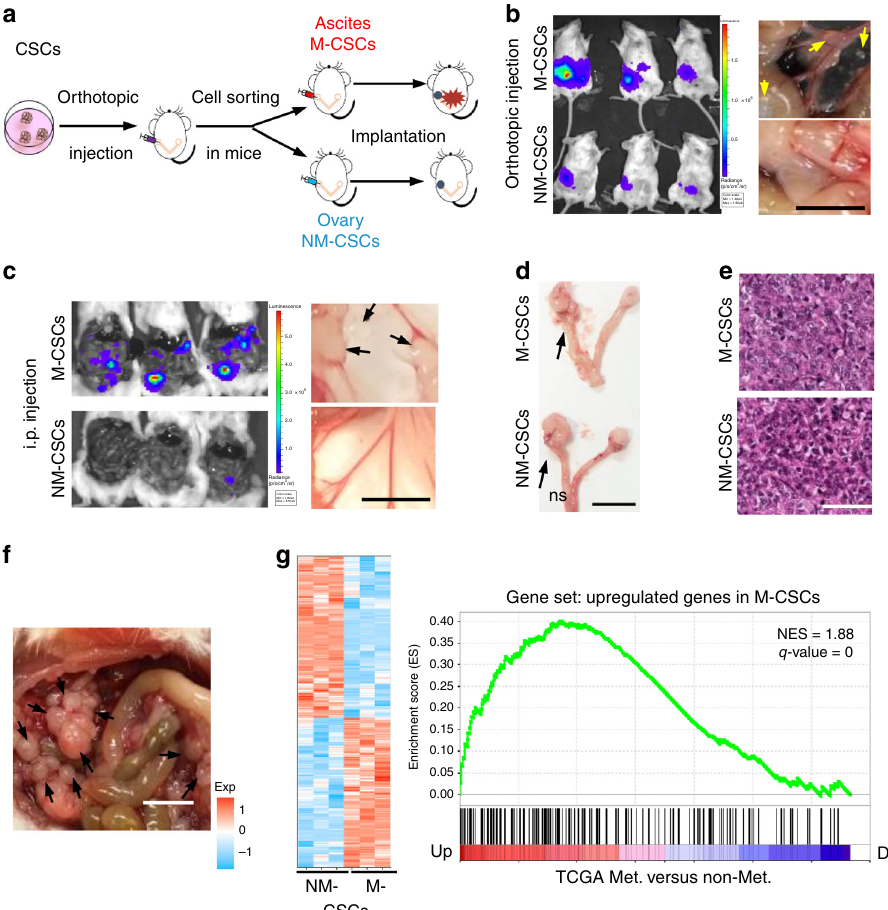
Fig. 1 Isolation and characterization of metastatic cancer stem cells. a Isolation of ovarian metastatic cancer stem cells. Blue circle, primary tumor. Red star, metastasis. b , c NOD/SCID mice engrafted with M-CSCs or NM-CSCs via b orthotopic or c i.p. injection. Left: representative bioluminescence image. Right: representative views of metastases in the peritoneal cavity. Arrows, metastases. Scale bar, 1 cm. n = 5 (orthotopic) or three mice (i.p) per group. d , e Representative image d of and H&E staining e of primary tumors from mice orthotopically transplanted with M-CSCs or NM-CSCs. Arrows, tumors. Scale bars = 1 cm d or 50 μ m e . f Representative view of metastasis in mice engrafted with M-CSCs of patient samples. Arrows, metastases. Scale bar, 1 cm. n = 7 mice, samples collected from three patients. g Gene expression patterns of M-CSCs and NM-CSCS compared with metastatic (Met.) versus non-metastatic (Non-Met.) tumors from TCGA RNA-seq data of ovarian cancer patients. Left: heat map representing genes in M-CSC and NM-CSCs. Rows represent different genes and column represents each sample. Blue: downregulation; Red: upregulation. Right: Gene Set Enrichment Analysis of differentially upregulated genes in M-CSCs samples against the ranked gene list (from up- to downregulated) in TCGA metastatic ovarian tumors. X axis from left to right: ordered genes from up- to downregulation in TCGA metastatic tumors. Experiments were conducted two a – f or three g , n = 3 per group) times independently. Results are represented with mean ± SEM. Statistical analysis using unpaired Student ’ s t test. ns, not signi fi cant. **, P < 0.01